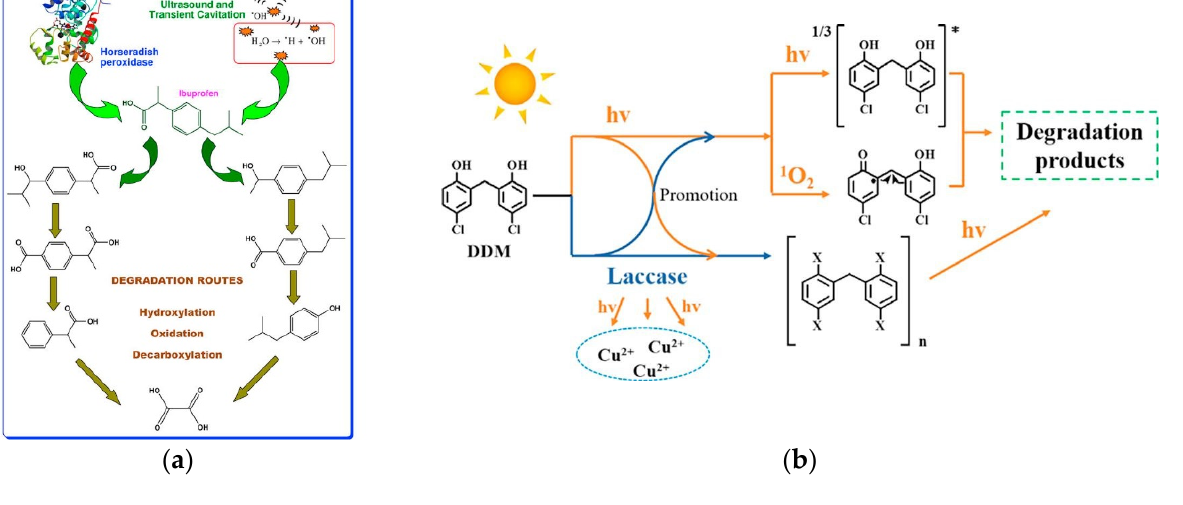
Figure 5. Degradation of IBP by sono-enzymatic treatment ( a ). Degradation of DDM by photolysis and Lac-catalysis in aqueous solution under simulated sunlight irradiation ( b ). Reprinted from Refs. [138,141], with permission from Elsevier. License Number: 5394210289329 and 5394210418986.